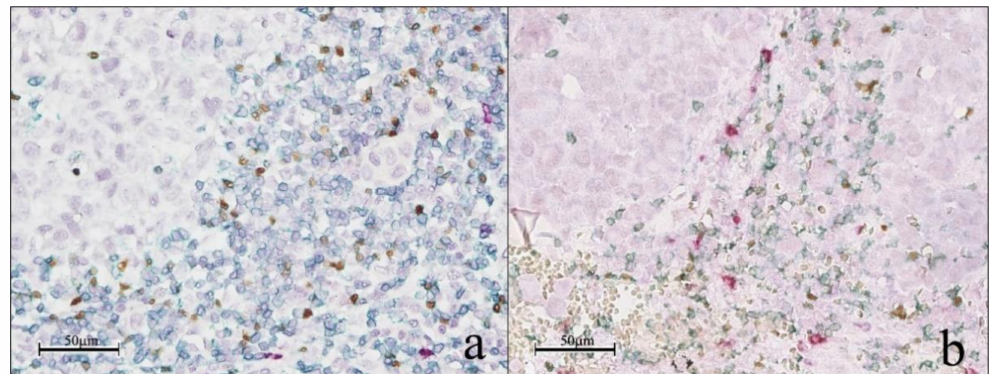
Figure 2. Multiplex immunohistochemistry. Representative image of multiplex immunohistochem- istry with CD3 (green), GRZB (red) and FOXP3 (brown) for sample with low ratio (< − 0.05) ( a ) and sample with high ratio ( ≥− 0.05) ( b